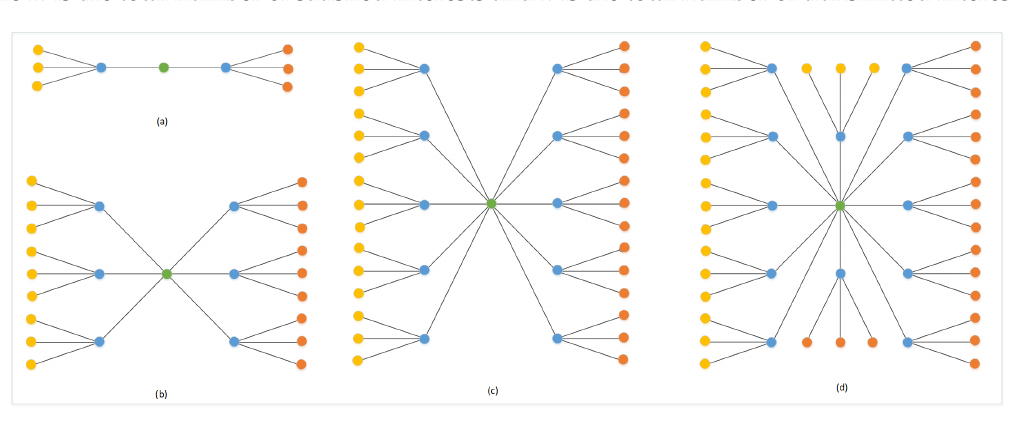
Figure 3. Network topologies: ( a ) 3 wireless access points, ( b ) 9 wireless access points, ( c ) 15 wireless access points, and ( d ) 21 wireless access